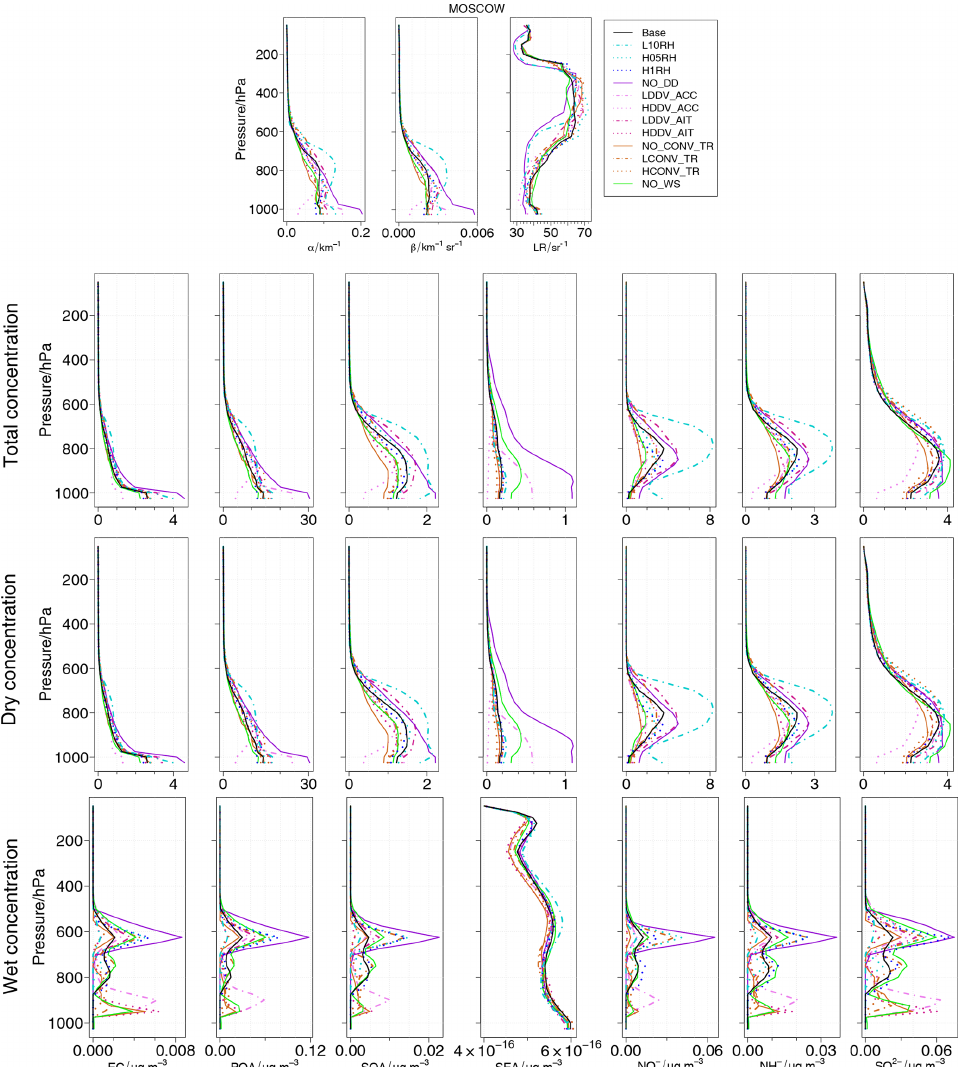
Figure 7. As Fig. 3 but over the Moscow